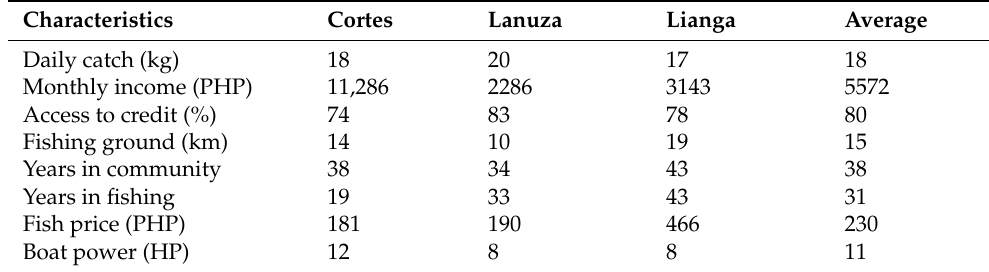
Table 2. Fishing characteristics of the small-scale fishers from the three municipalities.